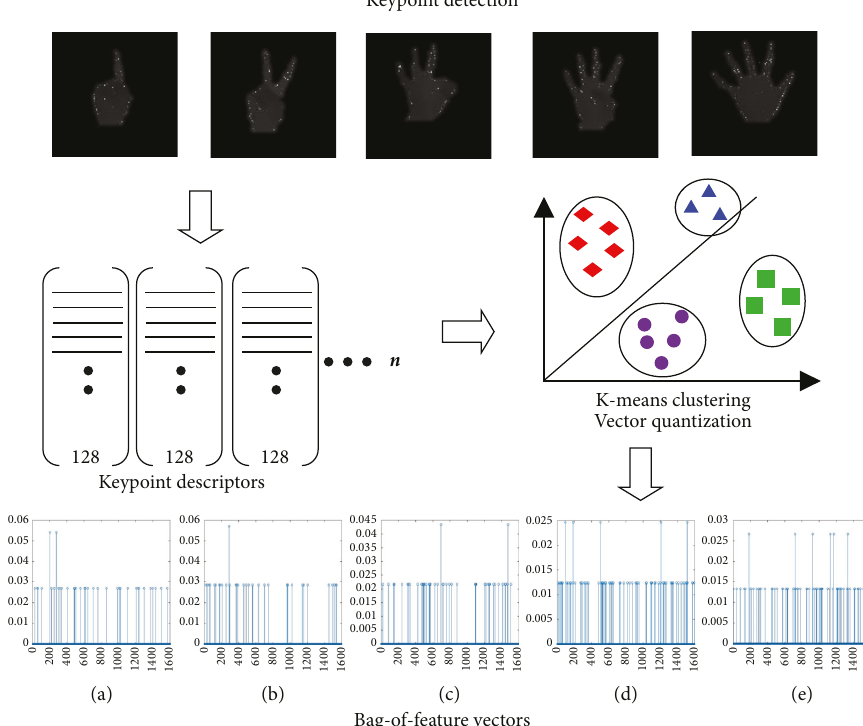
Figure 7: Generating bag-of-feature for training. (a)-(e) Bag-of-feature generated of gesture 2-6 from individual depth silhouette for 1600 clusters.